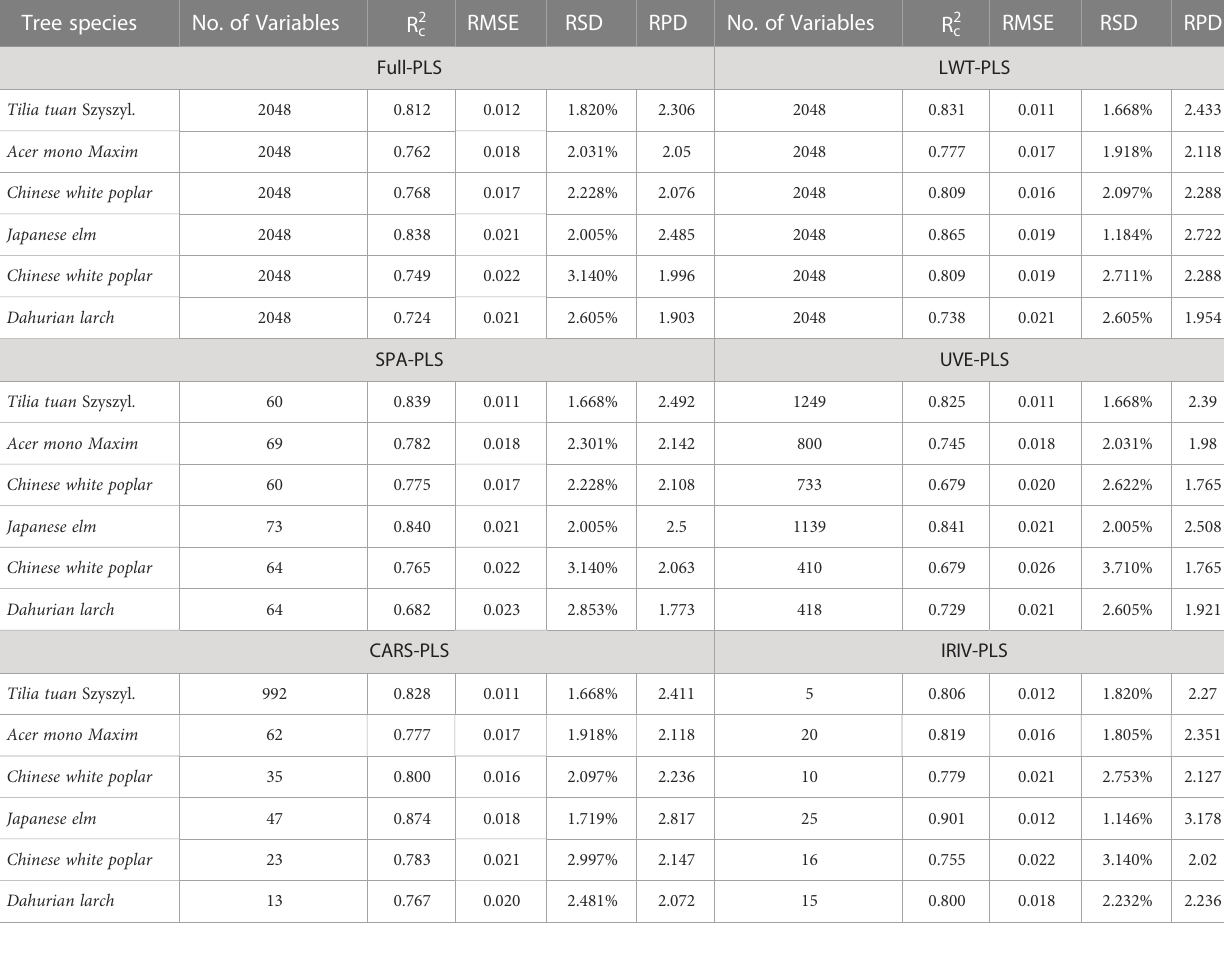
TABLE 2 The comparison of various variable selection methods for each tree species. Tree species